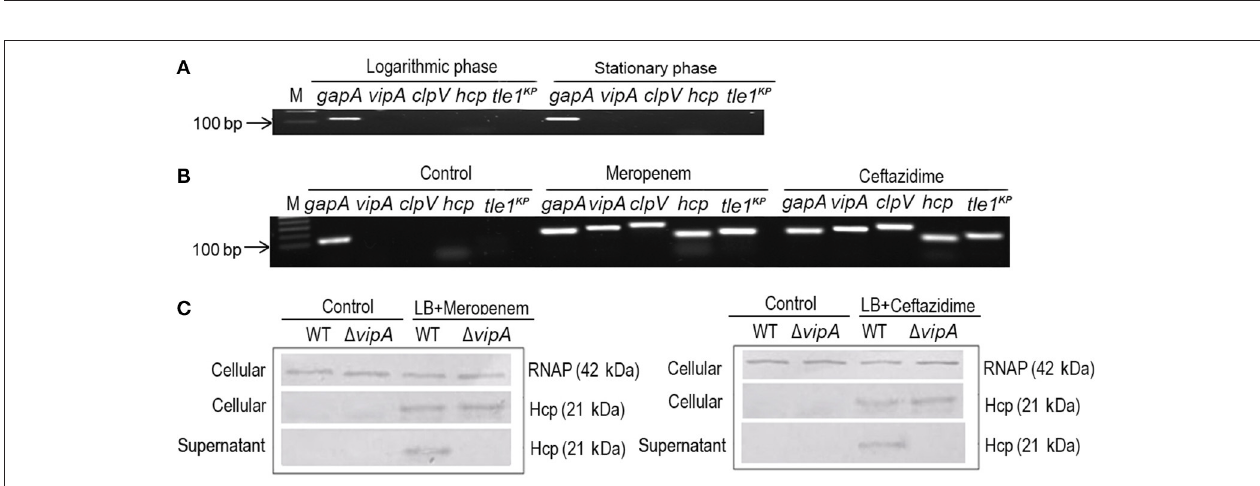
FIGURE 2 | The expression and secretion of T6SS of K. pneumoniae HS11286. (A) Semi-quantitative PCR was used to detect the expression of T6SS, with gapA as the reference gene, and samples were cultured with LB medium. vipA, clpV, hcp, and tle1 KP coded for tube sheath, ATPase, hallmark effector, and putative effector, respectively. (B) The expression of T6SS of K. pneumoniae HS11286 cultured with the addition of the sub-inhibitory concentration of 4 mg/L meropenem or 32 mg/L ceftazidime (Supplementary Figure 8). The gels were cropped from the original images available at the Supplementary Figure 6. (C) Immunoblots in the supernatant and cellular fractions of the HS11286 wide-type and 1 vipA mutant using specific antibodies against Hcp and RNAP (cellular control).